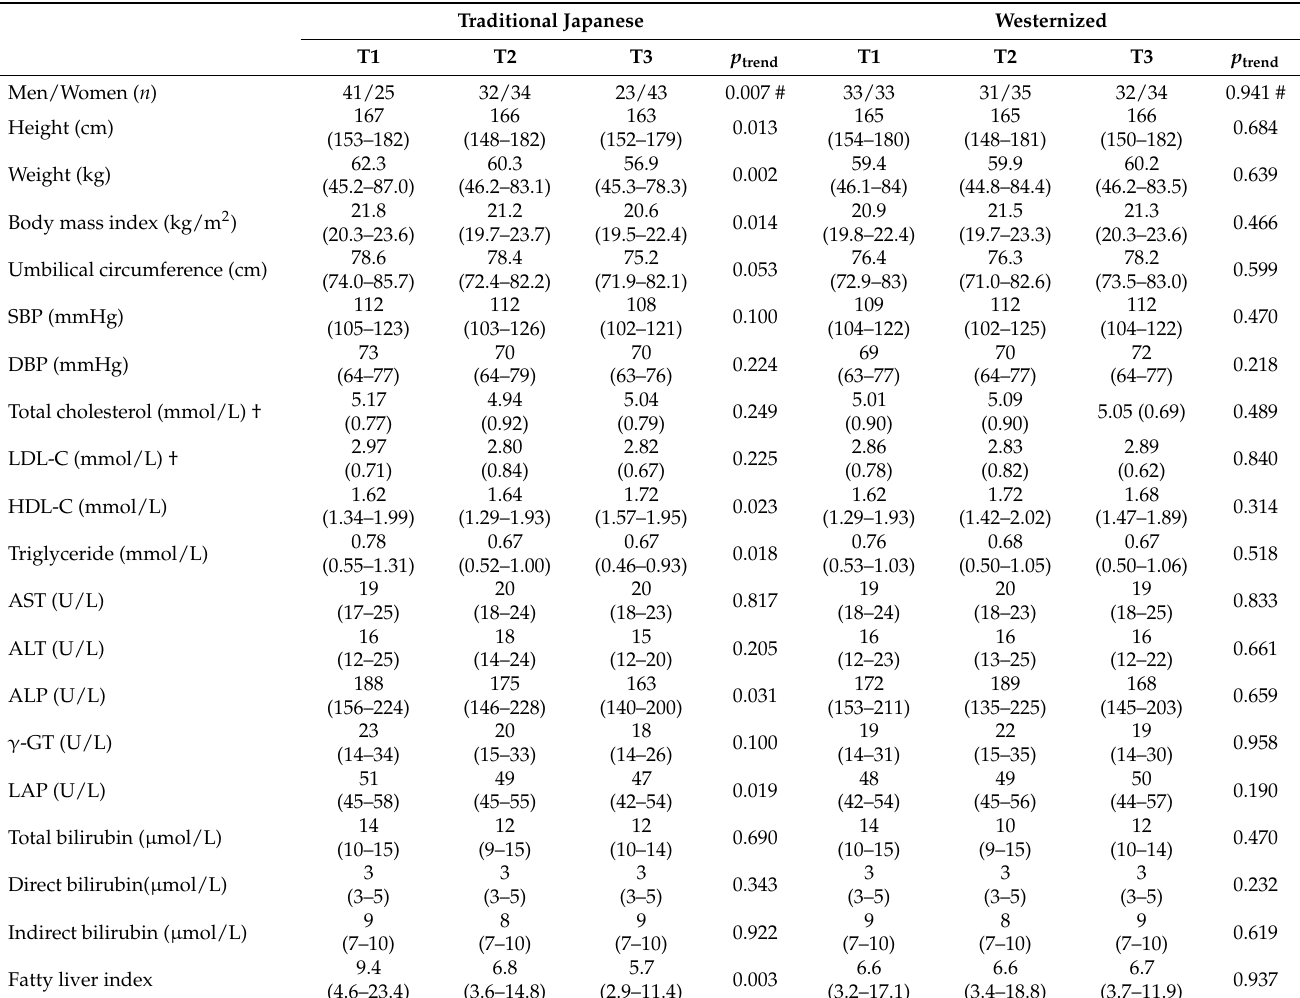
Table 5. Anthropometric, blood pressure, and biochemical parameters according to tertiles of the two food intake pattern